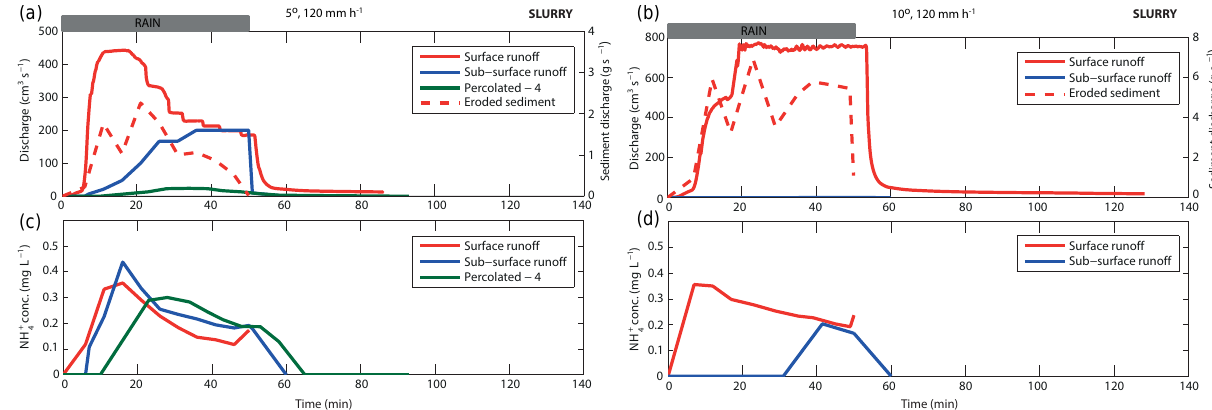
Figure 6. Plots showing water and sediment discharge (a, b) and NH + concentrations (c, d) from each monitored flow pathway for the 4 slurry-treated experiments at two slope angles (5 and 10 ◦ ) at 120mmh − 1 rainfall intensity. Where percolated 1–4 represent vertical transport from each of the pairs of tanks beneath the soil slope as marked in Fig. 1. Note: data which are absent reflect the lack of activation of a particular flow